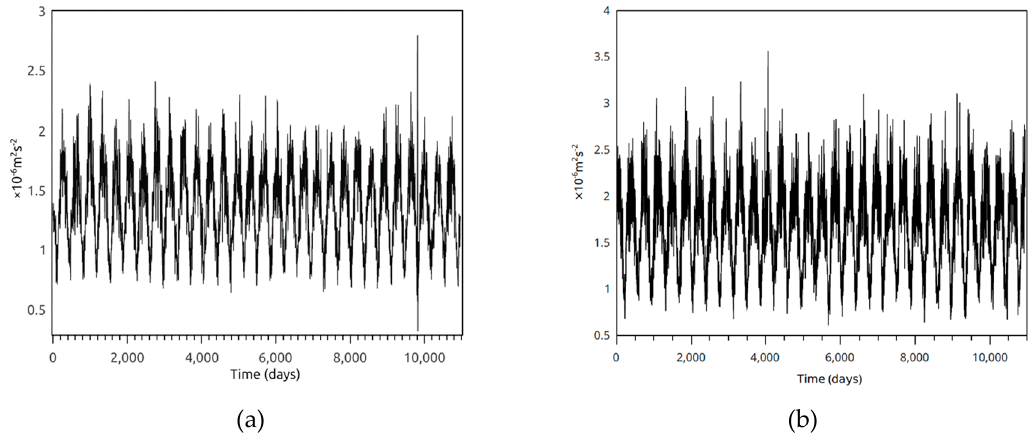
Figure 1. The Integrated Regional Enstrophy (IE) (× 10 − 6 m 2 s − 2 —ordinate) diagnostic derived from the Northern Hemisphere 500 hPa heights over the period 2020–2050 (abscissa), from the ( a ) Institut Pierre Simon Laplace Climate Model version 4 (IPSL-CM4) (left), and ( b ) Institut Pierre Simon Laplace Climate Model version 5 (IPSL-CM5) (right) model runs, and using a moderate emissions scenario.